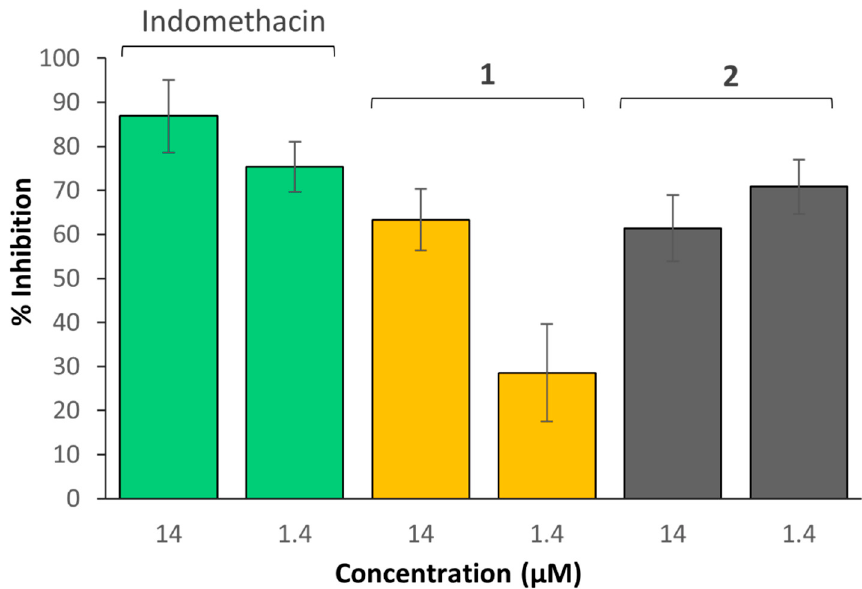
Figure 8. Inhibition of human COX-2 by 1 , 2 and indomethacin, at 14 and 1.4